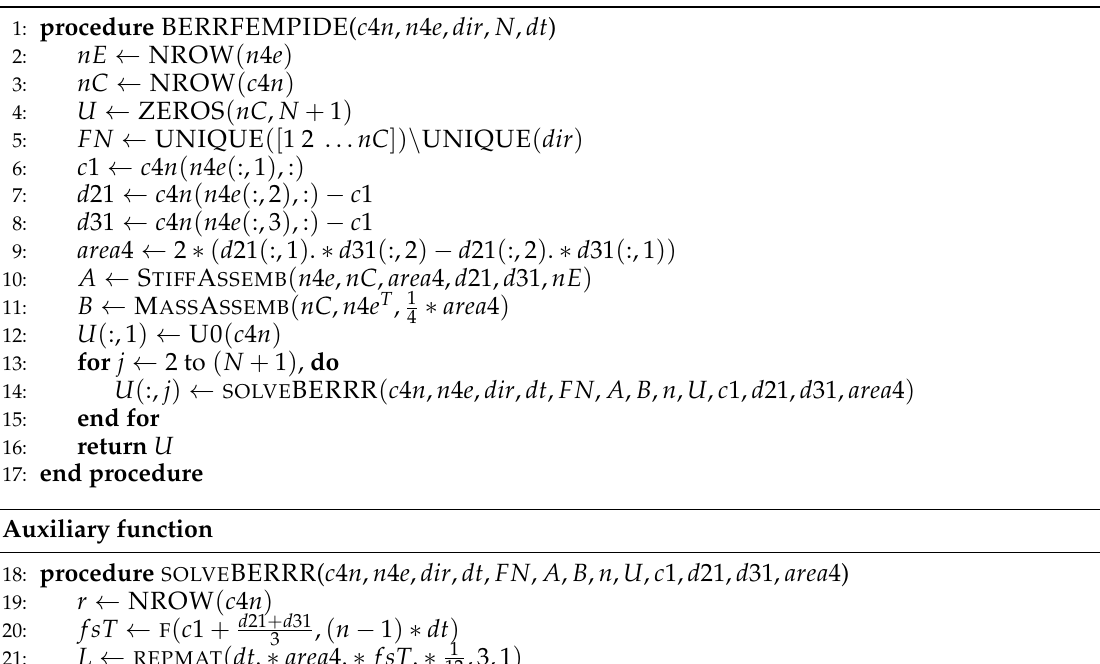
Algorithm A5 Vectorized version of backward-Euler scheme with the left rectangular rule. Main